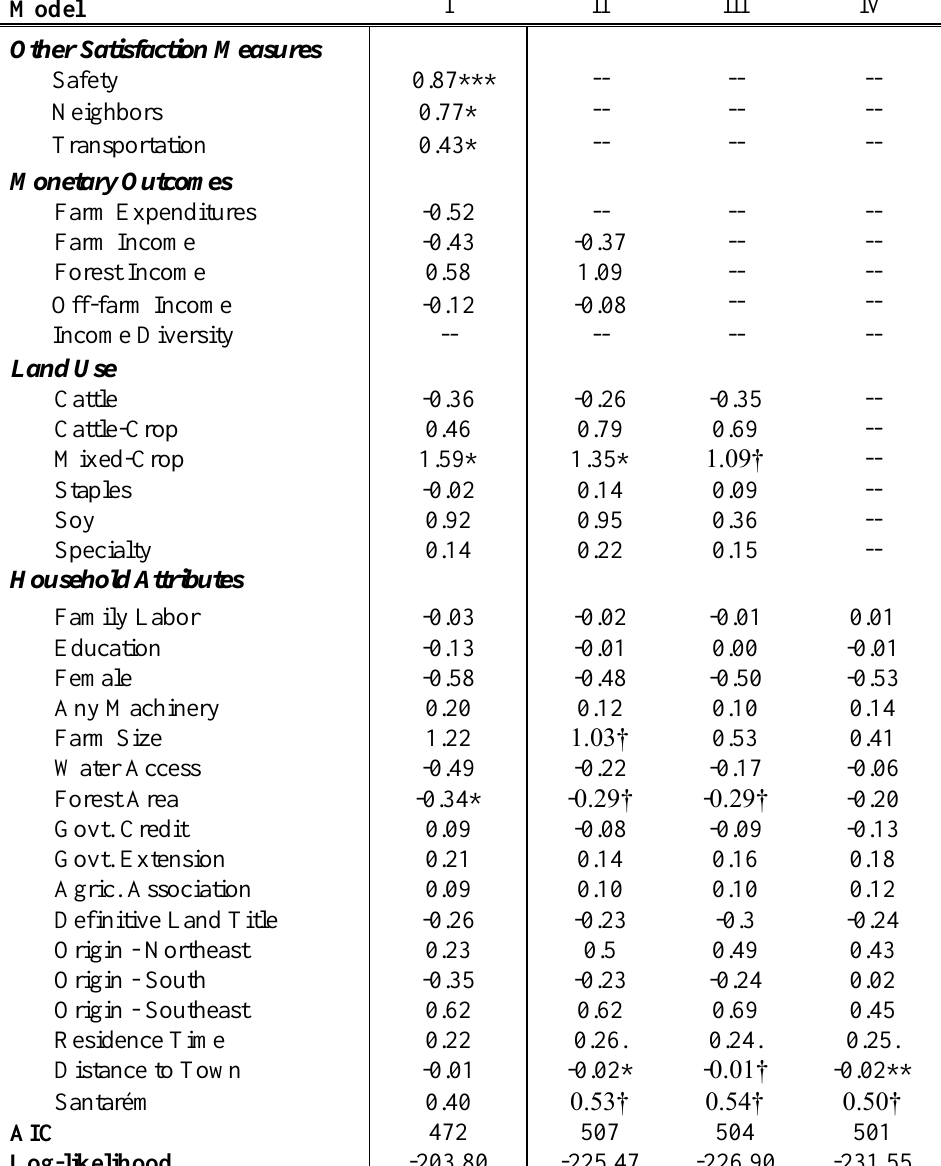
Table A3. 5 Additional results for ordered logit subjective wellbeing model